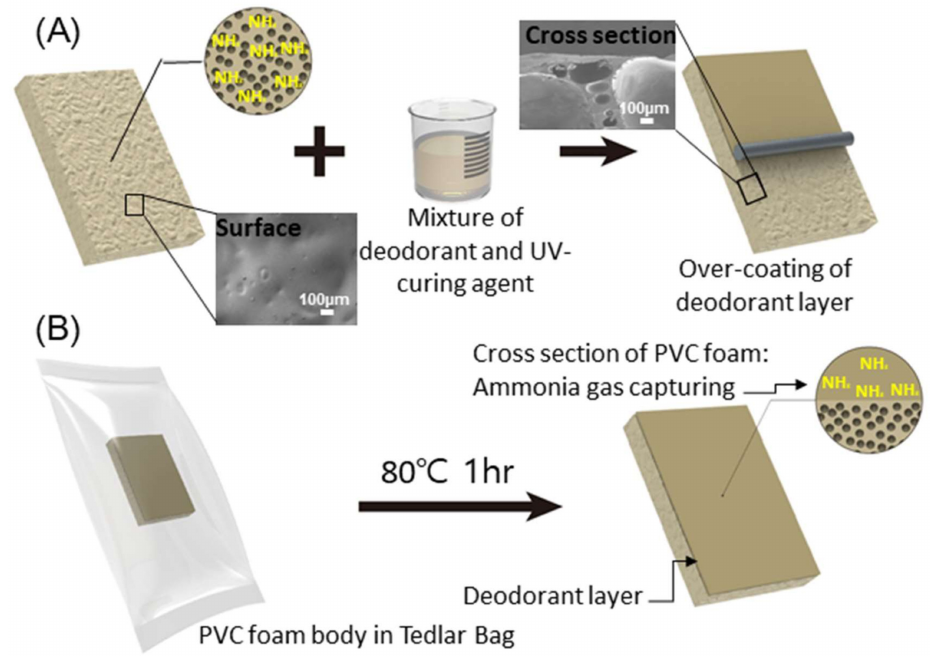
Figure 2. Schematics of experiments. ( A ) Over-coating process of deodorant layer on PVC foam. Inset: Scanning electron microscope (SEM) images of the surface and cross section of PVC foam before over-coating of the deodorant layer. ( B ) Ammonia emission/deodorization rate test using a Tedlar bag and the PVC foam after over-coating and absorption of ammonia gas by the deodorant